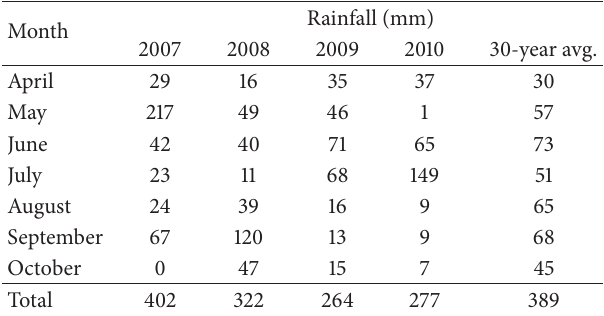
Table 1: Monthly rainfall totals for the 2007, 2008, 2009, and 2010 growing seasons and the 30-year average for Gaines County, Texas a